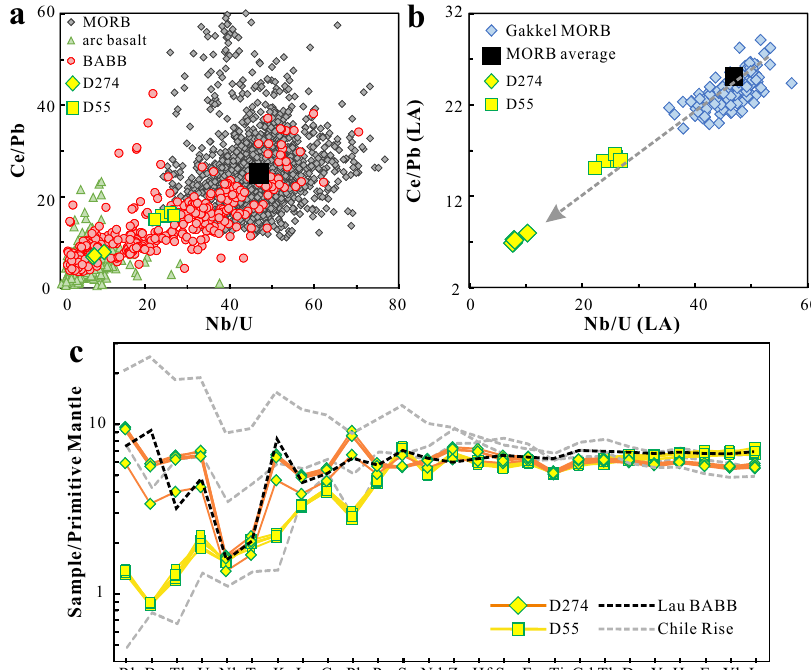
Fig. 1 Trace element characteristics of Gakkel mid-ocean ridge basalts. a Ce/Pb vs. Nb/U plot for convergent-margin like mid-ocean ridge basalts (MORB) from Gakkel (Dredge 274 & 55). Global MORB and back-arc basin basalts (BABB) from Gale et al. 15 , as well as arc basalts from Turner and Langmuir 63 are plotted for comparison. b New high-quality laser ablation (LA) data of Gakkel MORB show a positive Ce/Pb and Nb/U correlation. Gakkel MORB data were averaged per station (130 stations in total). Arrow shows the trend towards the in fl uence of subduction component in Gakkel MORB. Average Nb/U and Ce/Pb ratios for MORB (black square) are from Hofmann et al. 5 . c Primitive mantle normalized trace element diagram for the convergent-margin like Gakkel MORB. Primitive mantle values are from McDonough and Sun 64 . MORB samples from Chile Ridge with convergent margin- like characteristics 10 and average basalt compositions of Lau back-arc basin from 20 – 23°S calculated based on Gale et al. 15 are also